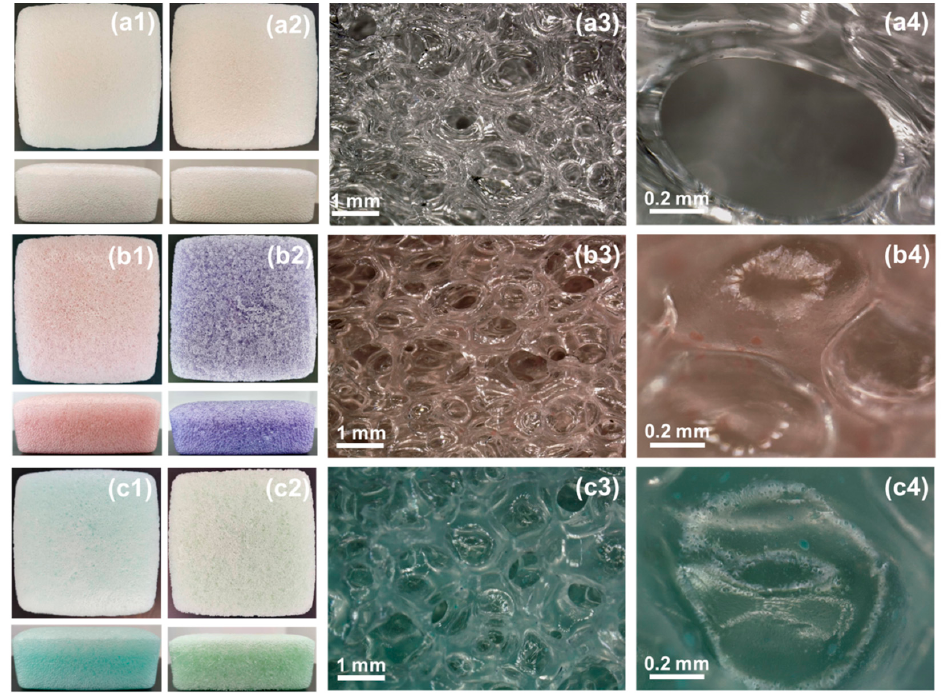
Figure 4. Photographs of the SiF/LDH nanocomposites before ( a1 , b1 , c1 ) and after ( a2 , b2 , c2 ) thermal treatment at 150 °C for 2 h (“13 cm × 13 cm” corresponding to the “length × wide” of the foams here). Microscopic surface topographies of the SiF/LDH nanocomposites ( a3 , a4 , b3 , b4 , c3 , c4 ). Table 2. The results of the density, LOI value, and vertical flame testing.